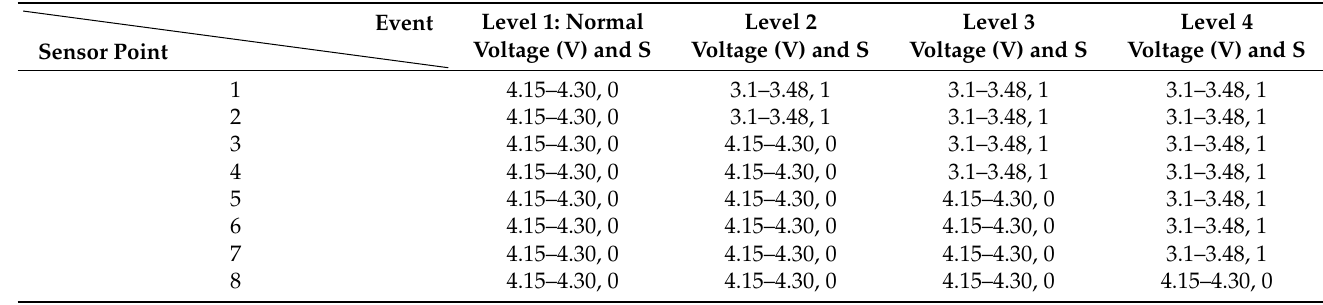
Table 1. Mean results of 10 experiments using artificial blood (2 – 10 mL).